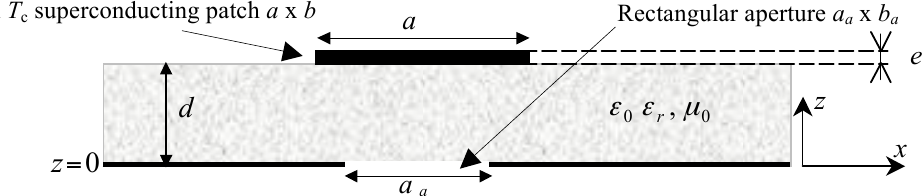
superconducting rectangular microstrip antenna with a rectangular aperture in c